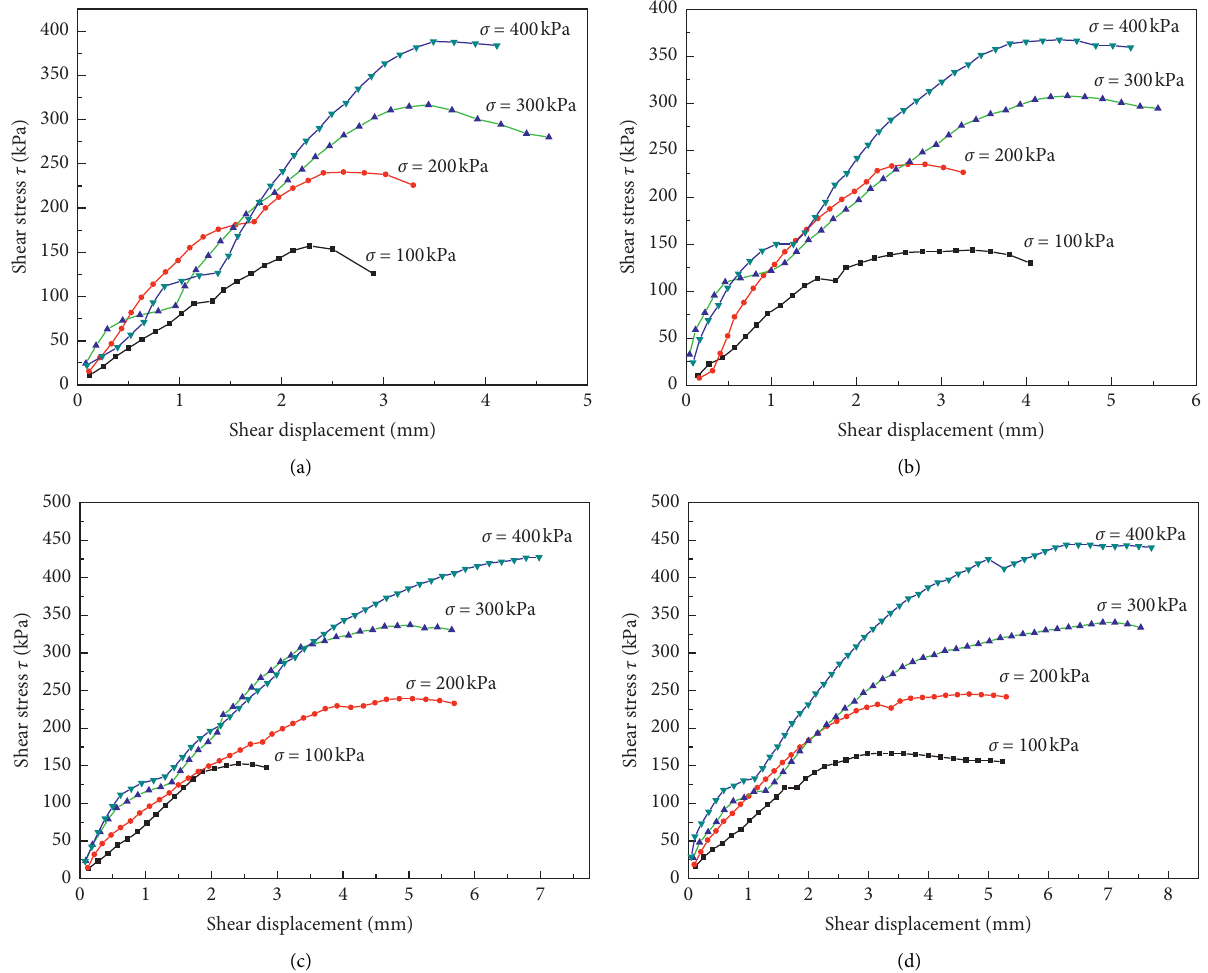
Figure 4: Shear stress-shear displacement curves of backfill body samples ( − 20 mm): (a) waste rock content of 10%, (b) waste rock content of 20%, (c) waste rock content of 30%, and (d) waste rock content of 40%.